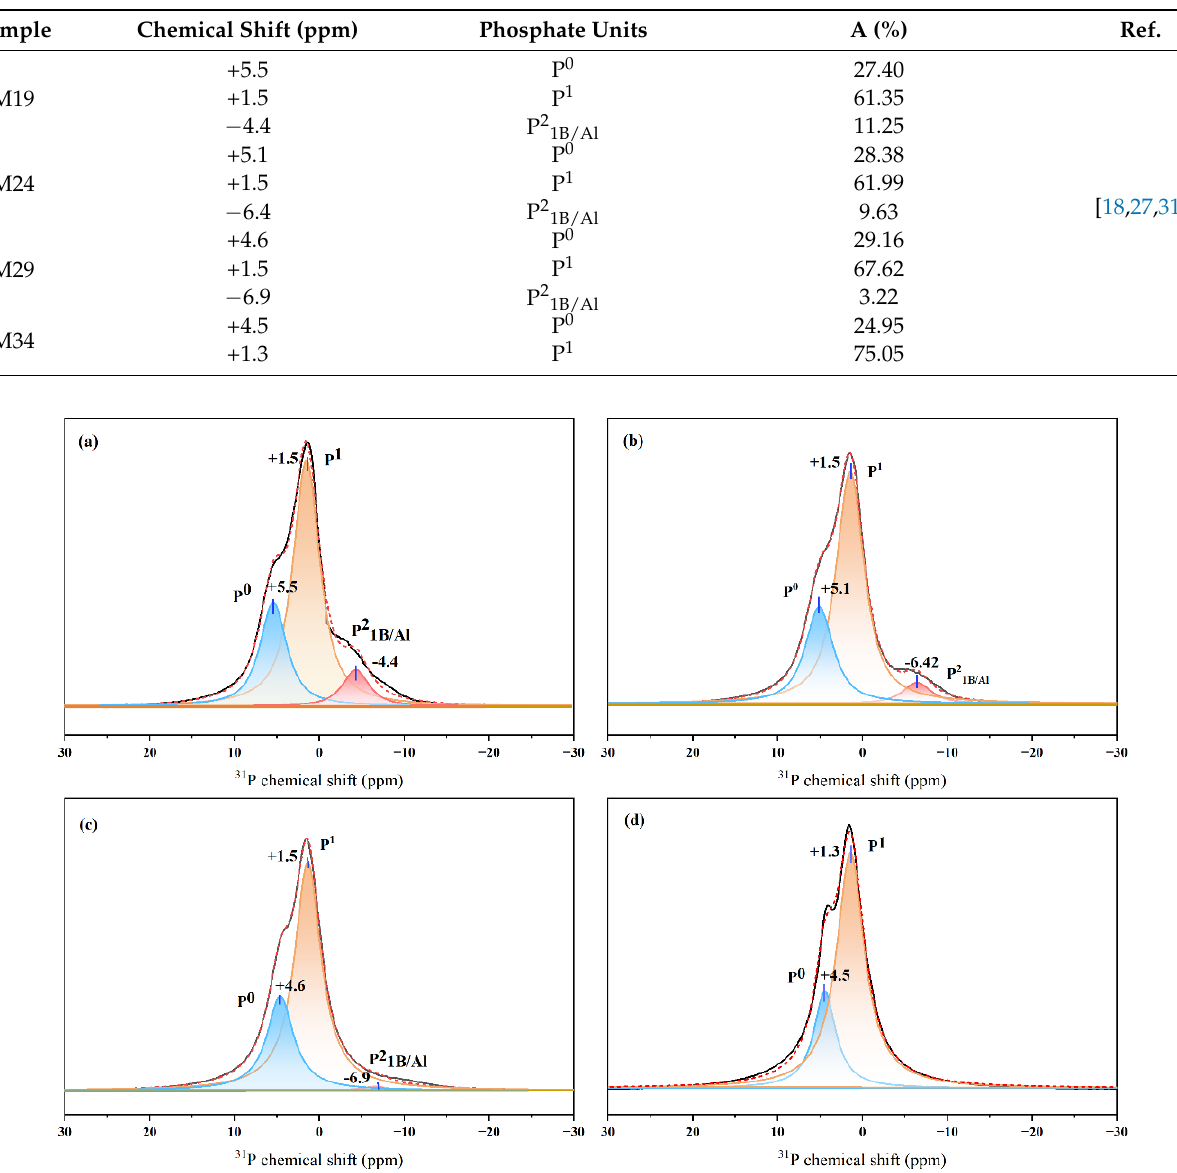
Table 4. 31 P MAS NMR fitting parameters (Chemical shift and relative area A).